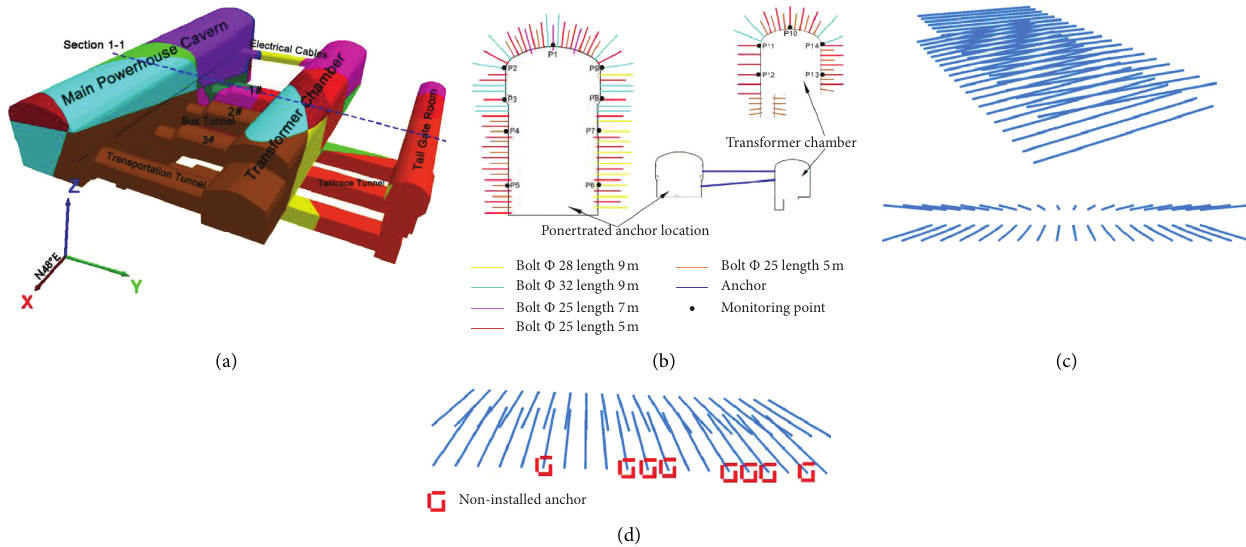
Figure 9: Caverns and tunnels in the Qiongzhong underground complex (a). The support system installed in the powerhouse cavern, and the monitoring points used in the numerical simulation are also shown (b). Twenty penetrated anchor bolts designed, demonstrated from two perspectives (c). The installation of 8 anchor cables has been canceled